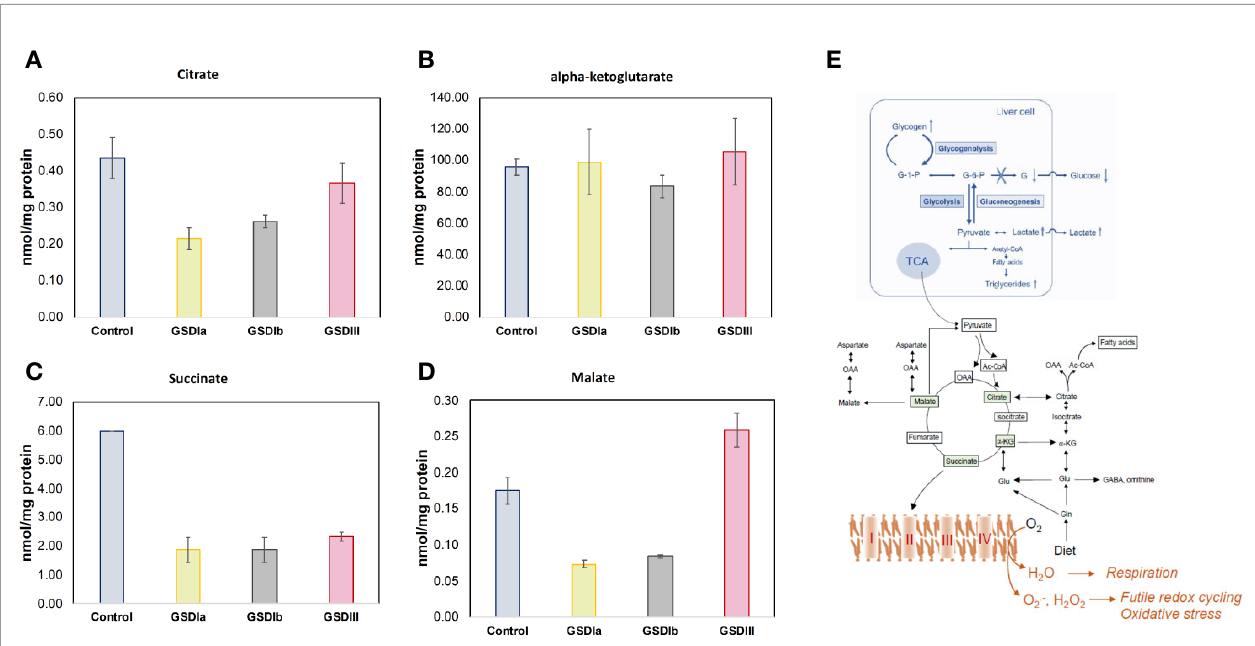
FIGURE 6 | Concentration of Krebs cycle intermediates in cells. Panels (A – D) show citrate, alpha-ketoglutarate, succinate, and malate concentration, respectively, determined in cell lysates after 5 days in culture. Metabolite concentrations were determined by LC-MS/MS and normalized by total protein concentration. No statistically signi fi cant differences were found between healthy control and GSD cells for citrate or alpha-ketoglutarate, suggesting no impairments in incoming precursors of the Krebs cycle. The concentration of succinate was reduced in all GSD cells with respect to healthy control cells. The concentration of malate was lower in GSDIa and GSDIb compared to healthy controls, but no differences were found between healthy controls and GSDIII. Panel (E) summary of GSD enzymatic impairment highlighting routes of carbon unit fl ow into the Krebs cycle (TCA) and respiratory chain. All individual comparisons were performed with one-way ANOVA, p<0.05. Control: n=2; GSDIa n =1; GSDIb n=1; GSDIII n=3, each by triplicate. Data are shown as mean ± standard error of the